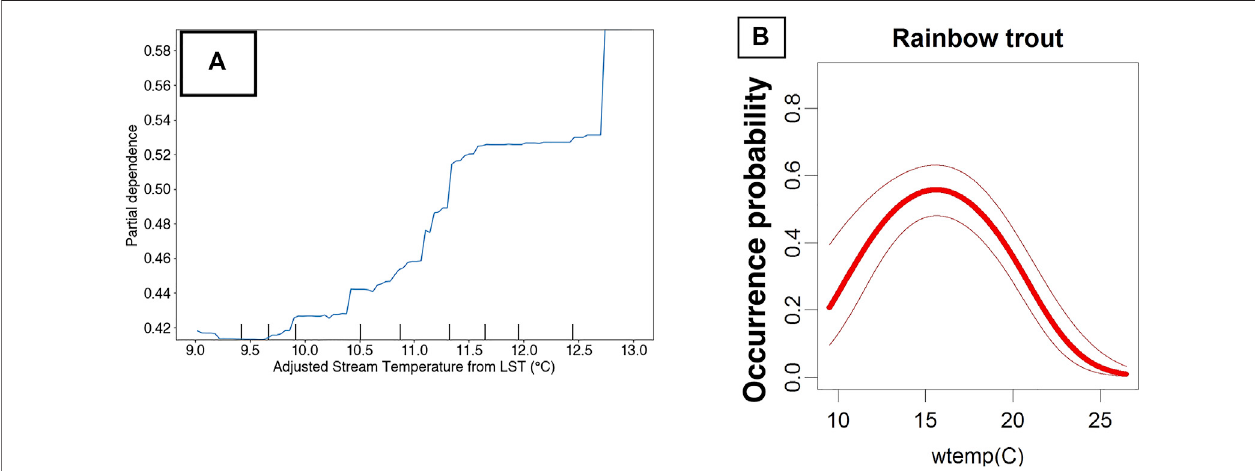
Frontiers in Big Data |